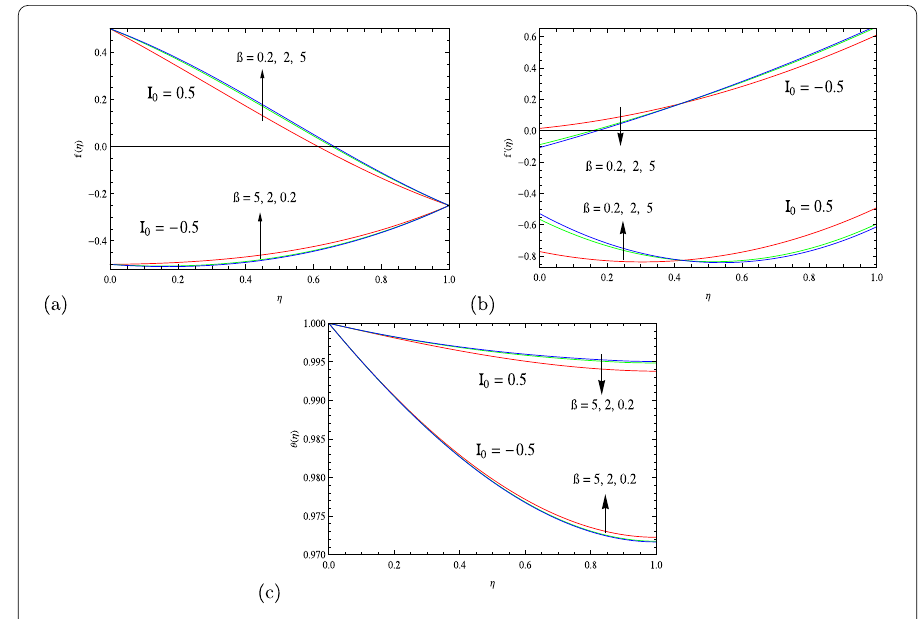
Figure 25 The effect of β on azimuthal velocity, velocity, and temperature profiles with Pr = 1, λ = 0.2, A = 0.3, N = 0.2, M = 1, Ma = 1, S = 0.4, Υ = 0.127013, Pr = 1